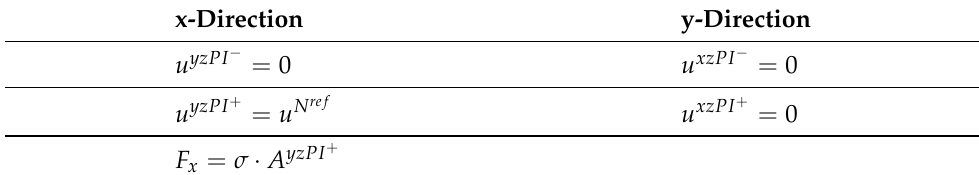
Figure 6. Two examples of random field realizations embedded in a reference FE model for a laminate of the thickness t lam with about 169,000 degrees of freedom. The upper half layers of the laminate are made transparent for visibility. The color indicates the relative displacements of the ply with respect to a nominal pristine position. Table 1. Applied values for boundary conditions to node sets and loads of the model.